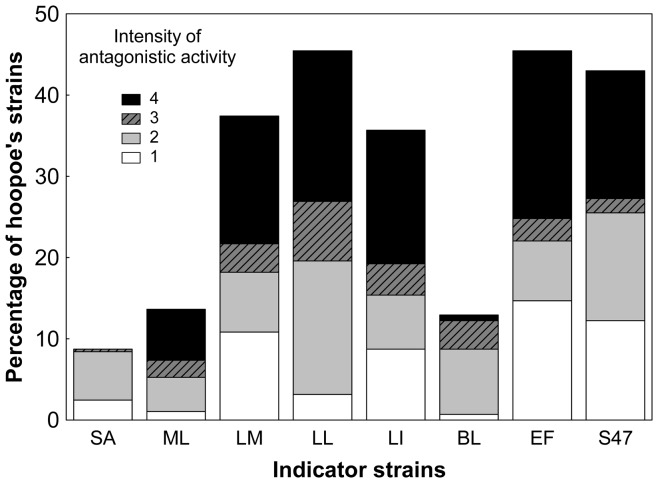
Intensity of antimicrobial activity.Variation in the inhibitory intensity against each indicator strain by symbiotic bacteria isolated from the uropygial gland secretion of hoopoes. (SA: S. aureus; ML: M. luteus; LM: L. monocytogenes; LL: L. lactis; LI: L. innocua; BL: B. licheniformis; EF: E. faecium; S47: E. faecalis). Intensity of antagonistic activity: 0 (no halo), 1 (ring width <1 mm), 2 (ring width = 1–2 mm), 3 (ring width = 3–4 mm), and 4 (ring width >4 mm.).